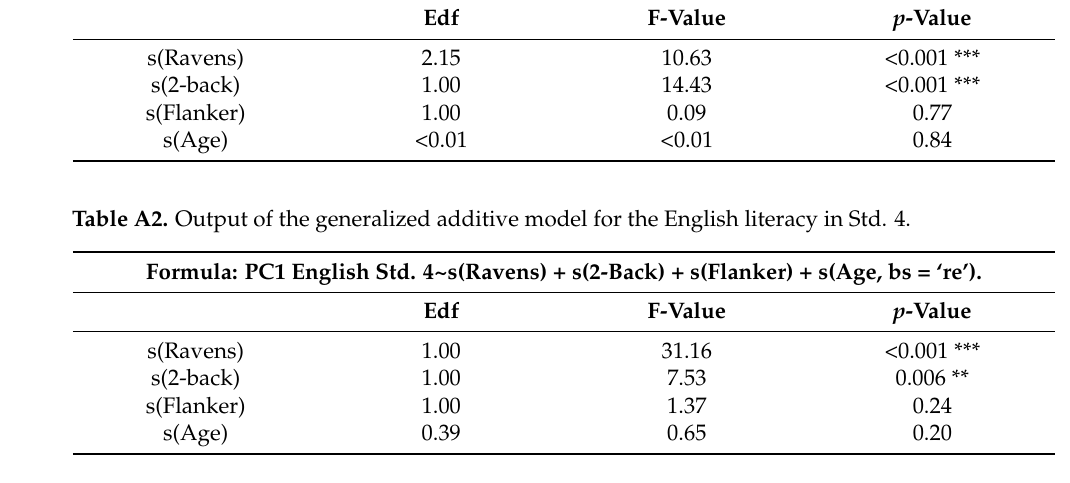
Table A3. Output of the generalized additive model for the Hindi literacy in Std. 5.